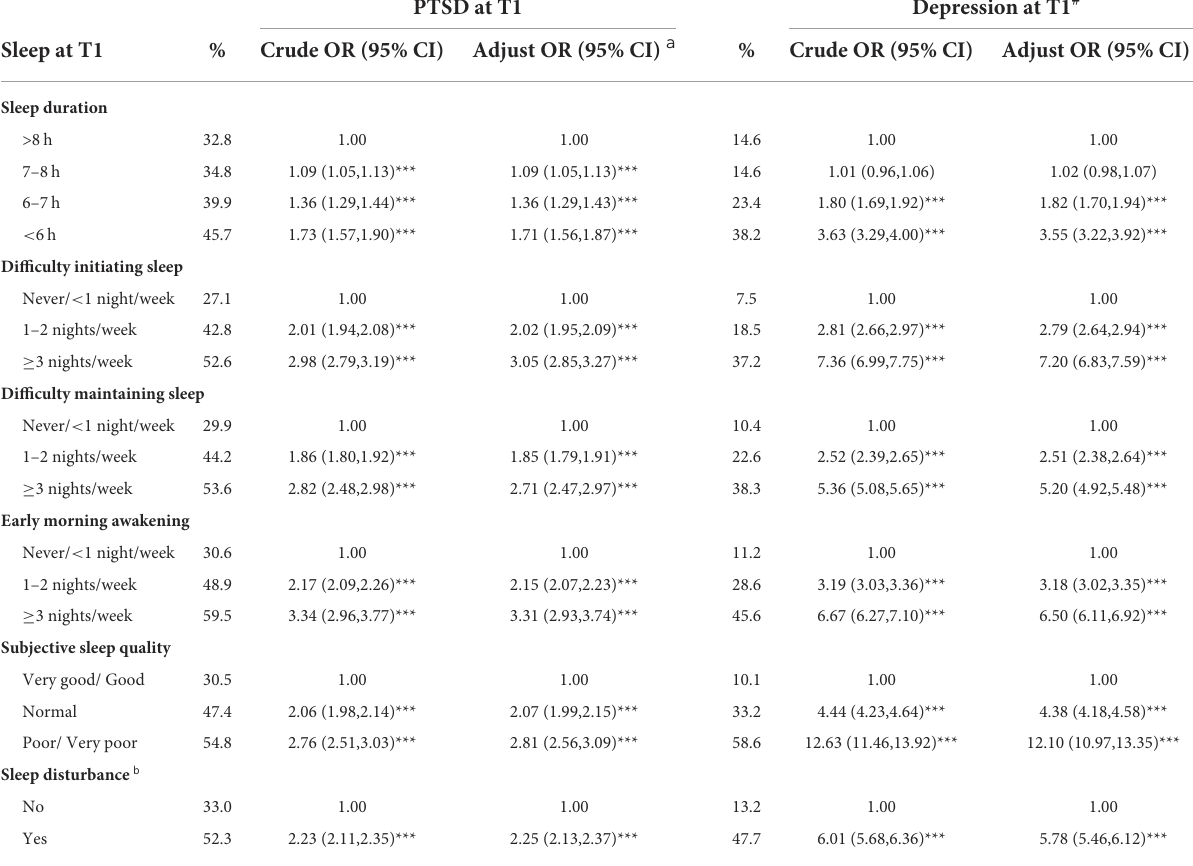
TABLE 2 Prevalence of PTSD and depression at T1 and their associations with sleep disturbance at T1. PTSD at T1 Depression at T1 # Sleep at T1 % Crude OR (95% CI) Adjust OR (95% CI) a % Crude OR (95% CI) Adjust OR (95% CI)